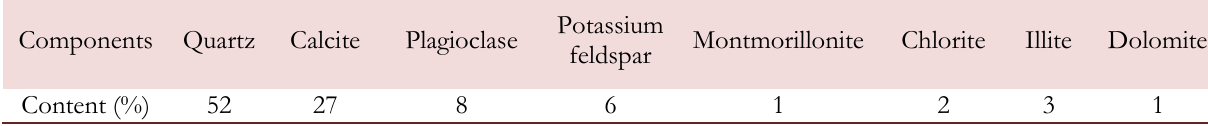
Table 2: Component of